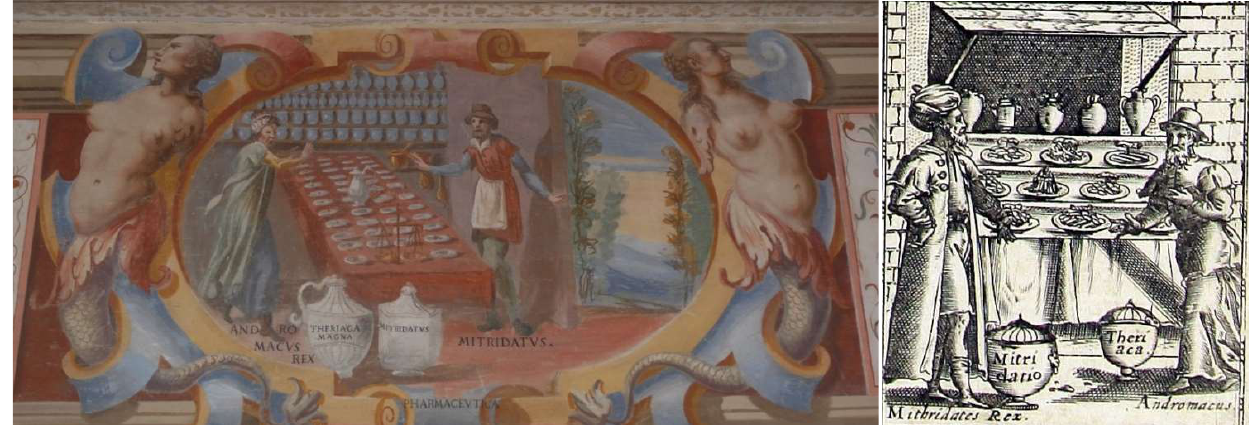
Figure 12. Left : The oval painting depicts Mithridates and Andromachus in a pharmaceutical workshop. Right : A very similar scene is present in Giunti’s frontispiece.